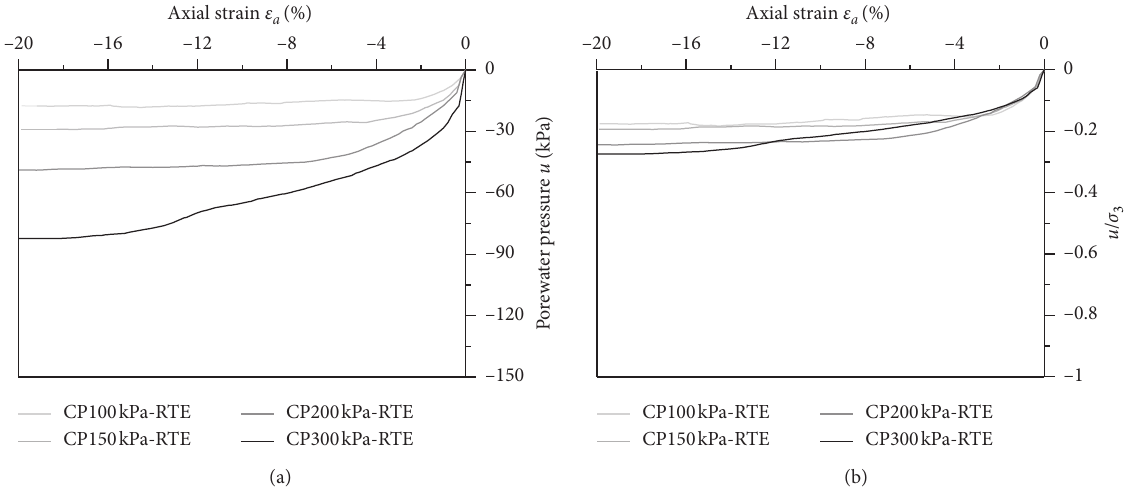
a and (b) u / σ 3 versus axial